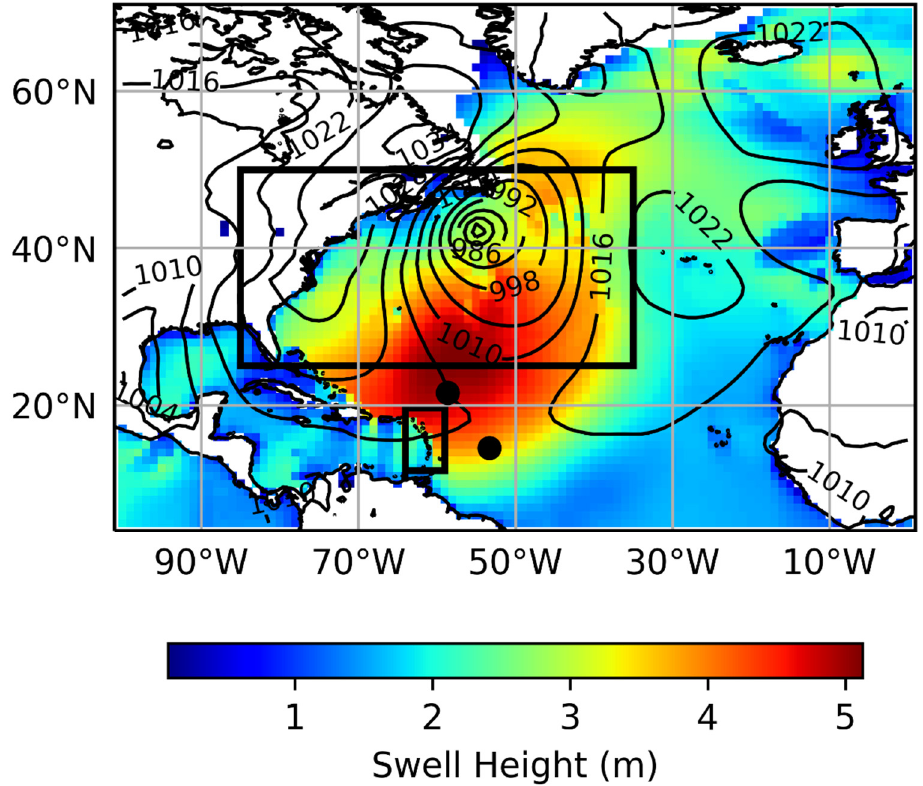
Figure 1. Study area and atmospheric and ocean swell conditions from the ERA5 reanalysis during the largest north swell event in the analysis. The map bounding box is the area for which composite maps are created. The large rectangle is the area for which storms are identified while the small rectangle is the eastern Caribbean north swell study area. Circles are NOAA buoys 41040 (14.5 ◦ N, 53.3 ◦ W) and 41044 (21.6 ◦ N, 58.6 ◦ W). Shading indicates swell height on 20 March 2008, the highest day of the highest swell event during the study period (see Table S1), and contours indicate sea level pressure, with a 6 hPa interval, two days prior on 18 March